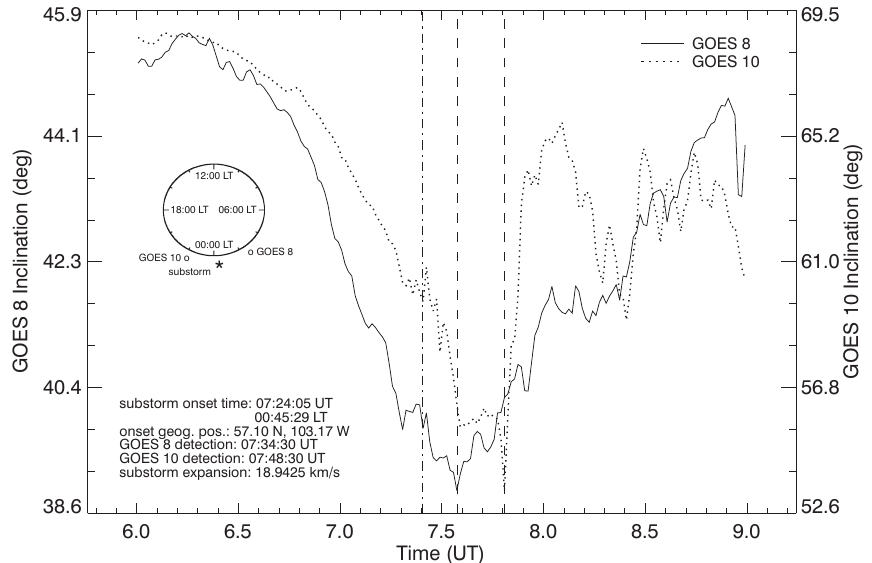
Fig. 1. Temporal variation in magnetic inclination calculated from GOES 8 and GOES 10 magnetometer data on 31 August 2000. Substorm onset is indicated by the vertical dash-dot line and GOES detection of dipolarization fronts by dashed lines at the local inclination minimum for each satellite. Also plotted is a local time dial showing local time of substorm onset relative to each